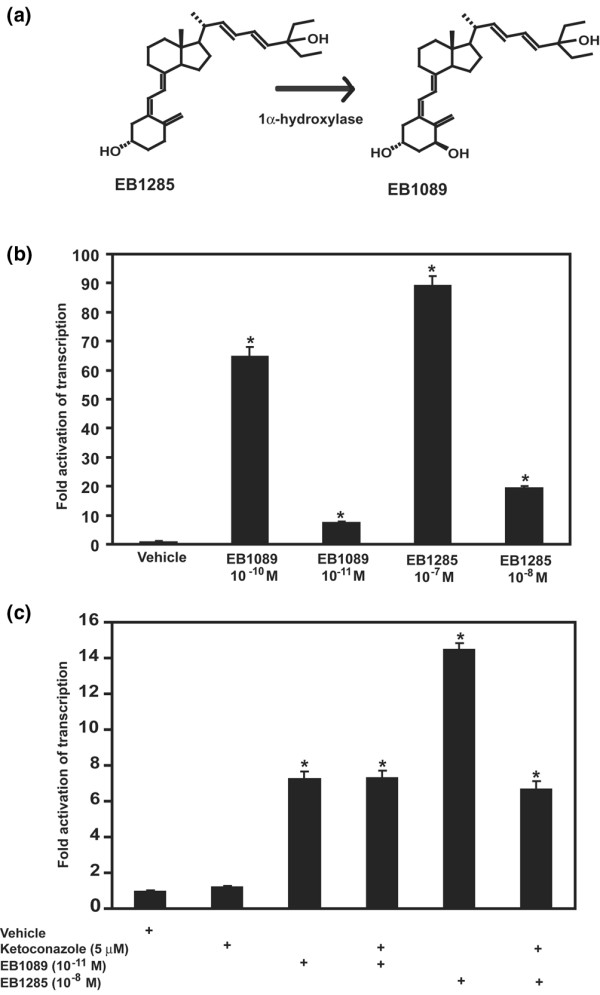
Transcription activity of EB1285 in MCF-7 cells. (a) The chemical structure of the vitamin D analogue EB1285 before and after (EB1089) 1α-hydroxylation. (b) VDR-directed transcription activity of EB1089 or EB1285 in transfected MCF-7 cells. (c) Activation of transcription in the presence of the cytochrome P450 inhibitor ketoconazole. Asterisks represent p < 0.001.